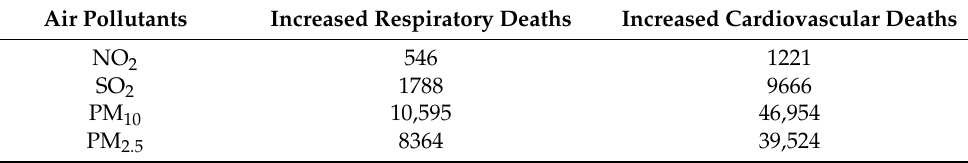
Table 4. Increased number of disease deaths caused by exposure to air pollutants.